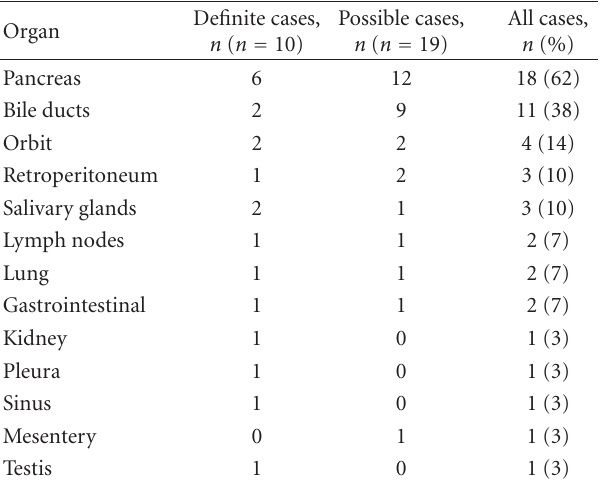
Table 3: Spectrum of organ involvement in patients with IgG4-RD ( n =